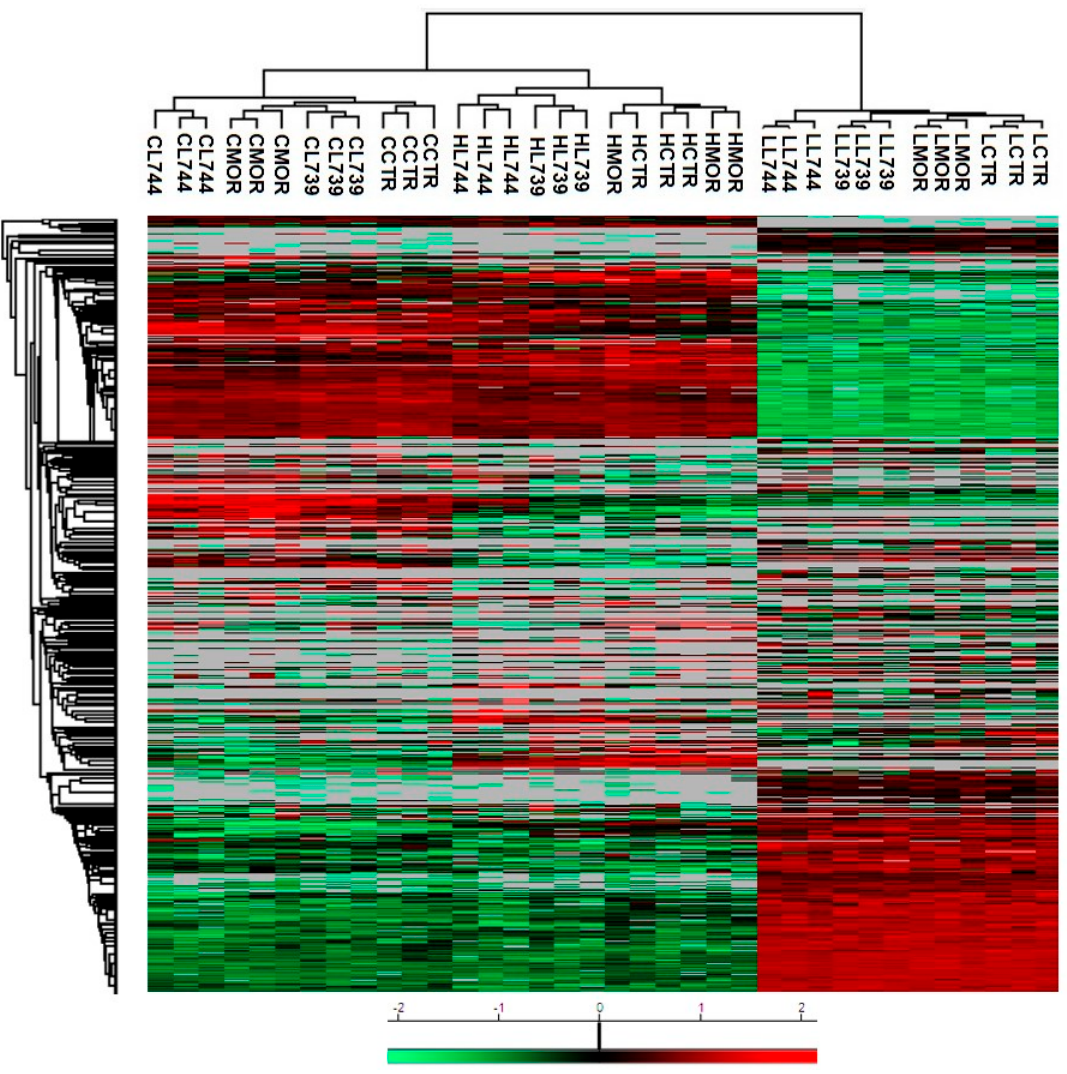
Figure 3. Heatmap showing hierarchical clustering performed on LFQ intensity values (with Perseus software version 1.6.15.0) of all 4717 proteins identified in rat spleen lymphocytes (L), brain cortex (C), and hippocampus (H) after 7-day treatment with 3 mg/kg of morphine ( MOR ), LYS739 , and LYS744 . Significantly upregulated proteins are labeled in red, significantly downregulated proteins are labeled in green. L739, LYS739 ; L744, LYS744 .